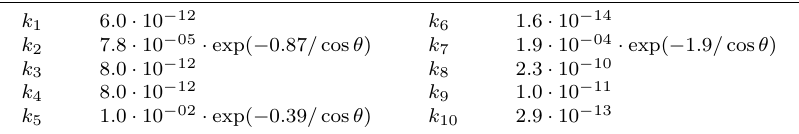
Table 2. The coefficients of the chemical reactions. k 1